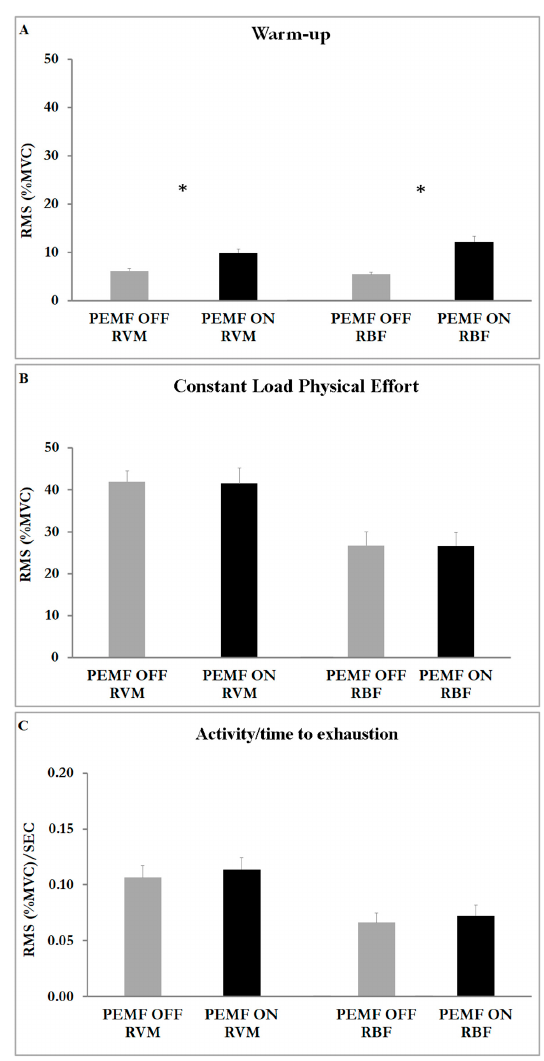
Figure 3. Histograms represent the root mean square (RMS) of the normalized EMG values (mean ± SEM) of both muscles (RVM; RBF) in both stimulations (ON; OFF). ( A ) EMG activity at warm-up. ( B ) EMG activity at phase of constant-load physical effort. ( C ) EMG activity related to the time of exhaustion. Asterisks indicate significant differences at p < 0.05. We measured the blood lactate concentration (mmol/L) before the beginning of the exercise session (baseline) and at the third minute of the constant-load physical effort (Figure 4). The analysis showed a significant difference between PEMF ON (10.05 ± 0.65 mmol/L) and PEMF OFF (7.48 ± 0.42 mmol/L) for the lactate concentration recorded during the constant-load exercise (t(19) = − 4.78; p < 0.001; ES 0.46—moderate).